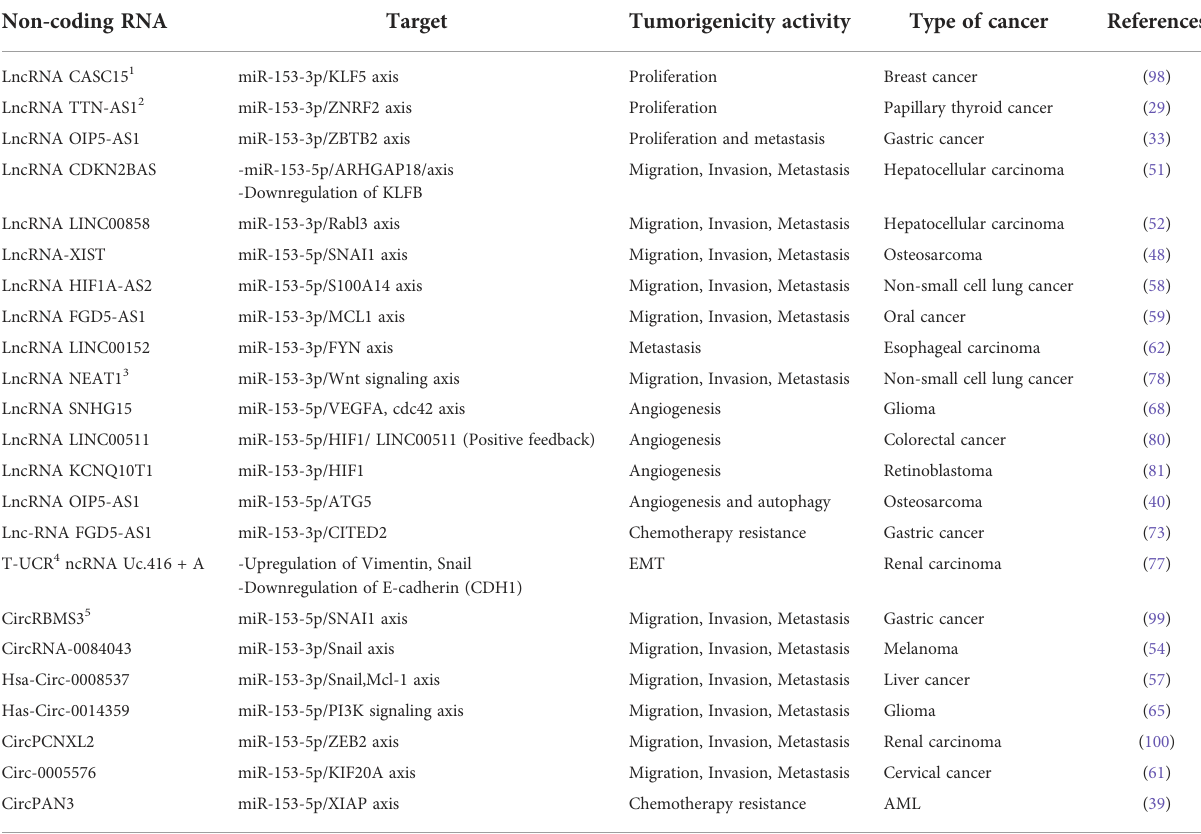
TABLE 3 Non coding RNAs modulating the expression of miR-153 in different cancer cells. Non-coding